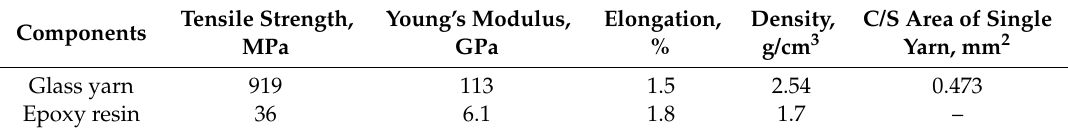
Figure 1. ( a ) Woven structure and ( b ) microscopy image of unidirectional glass fiber fabric. Table 1. Physical and Mechanical Properties of GFRP components (The mechanical properties of glass yarn are obtained under quasi-static loading condition and gauge length of specimen is 25 mm. Those of epoxy resin are provided by